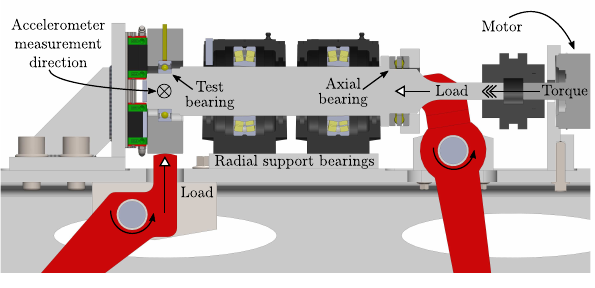
Figure 6: Test rig 2 Klausen et al. (2017a).